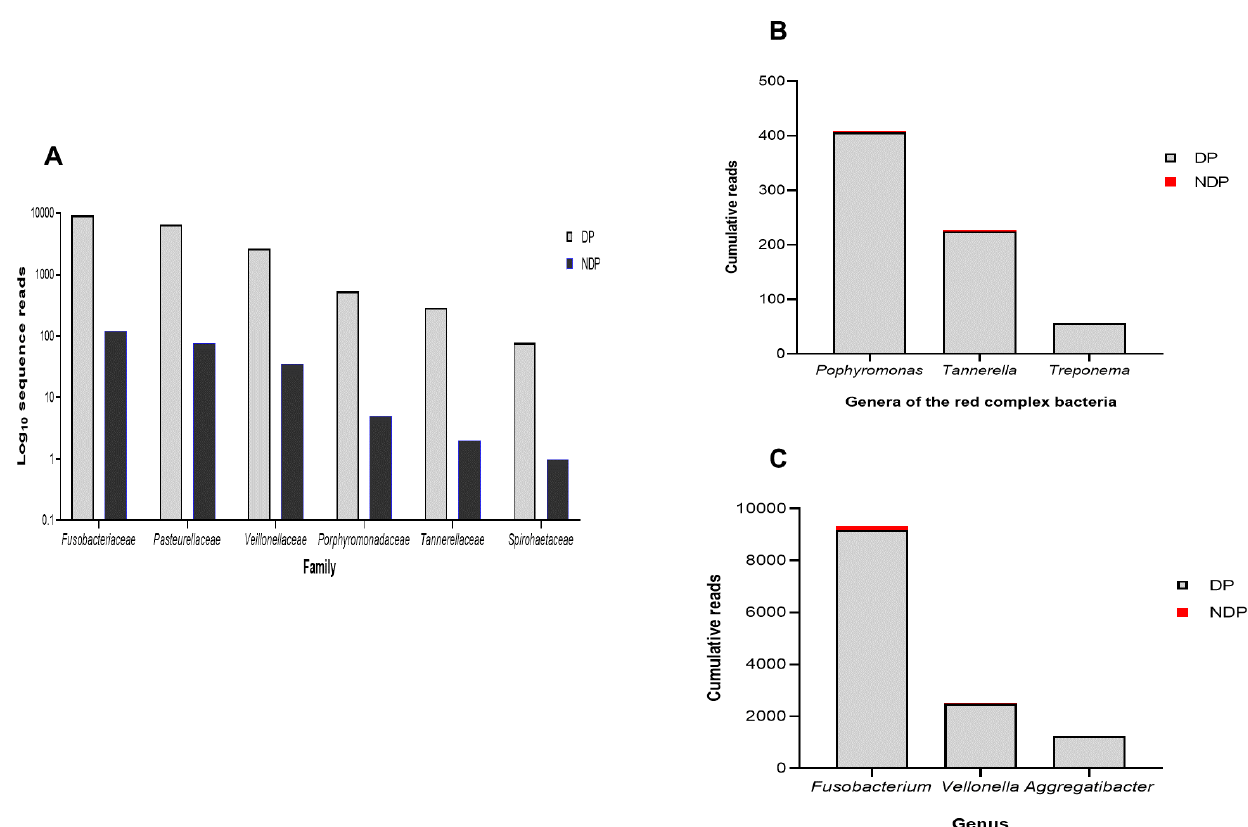
Figure 2. Subgingival microbiota of diabetic (DP) and non-diabetic (NDP) patients. Relative abundance of ( A ) six bacterial families; ( B ) genera of the red complex bacteria; ( C ) genera of selected non-red complex bacteria.